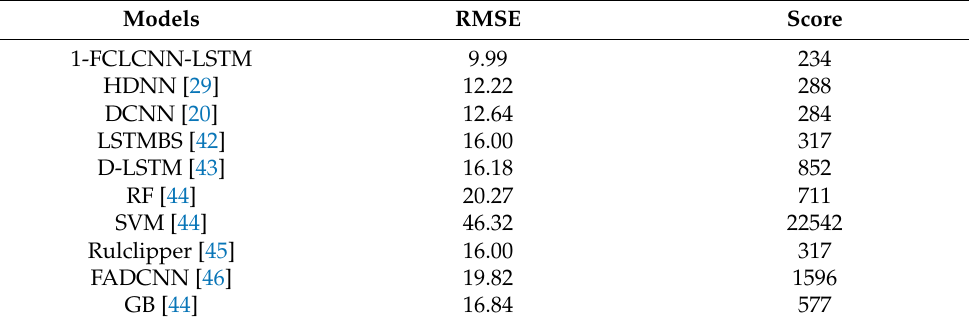
Table 8. Comparison results of various models on the FD003